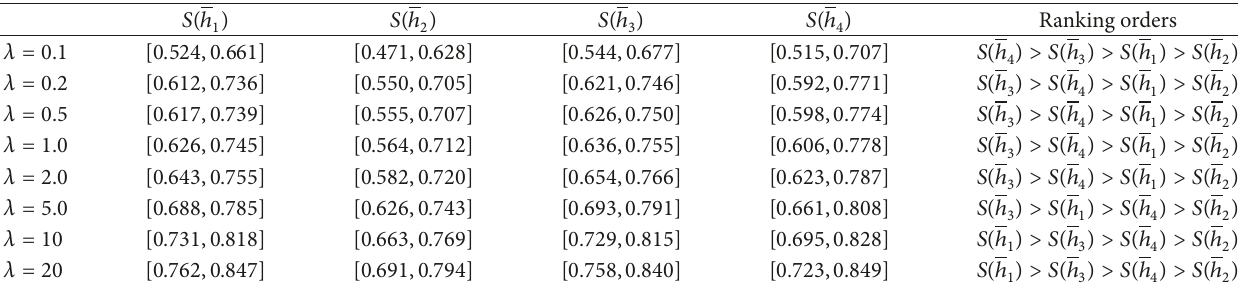
Table 12 indicates that the different ranking results